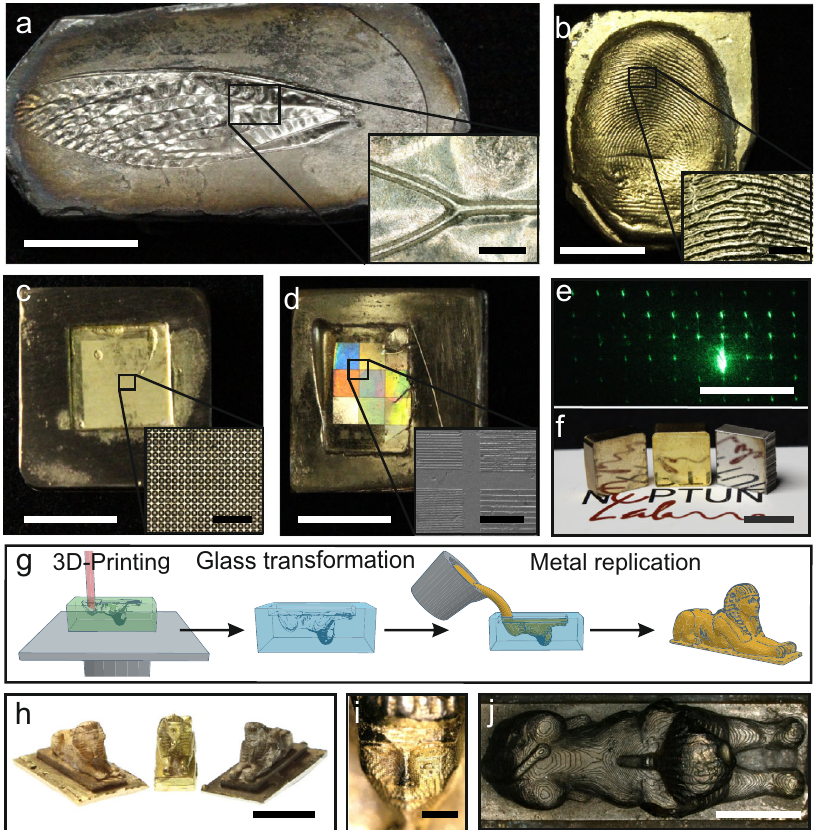
Fig. 4 | Various examples from nature and technology for the applicability of the described metal replication process. a Cicada wing made of a cobalt- chromium alloy (scale bar: 10mm, magni fi ed view scale bar: 500 µ m). b Metal replication of a human fi ngerprint in brass (scale bar: 10mm, magni fi ed view scale bar: 500 µ m). c Microlens array in brass with a lens diameter of 30 µ m (scale bar: 10mm, magni fi ed view scale bar: 200 µ m). d Bronze metal replication of different lines-and-space structures in the range of 5 – 25 µ m in bronze showing interference effects (scale bar: 10mm, magni fi ed view scale bar: 100 µ m). e Function test of